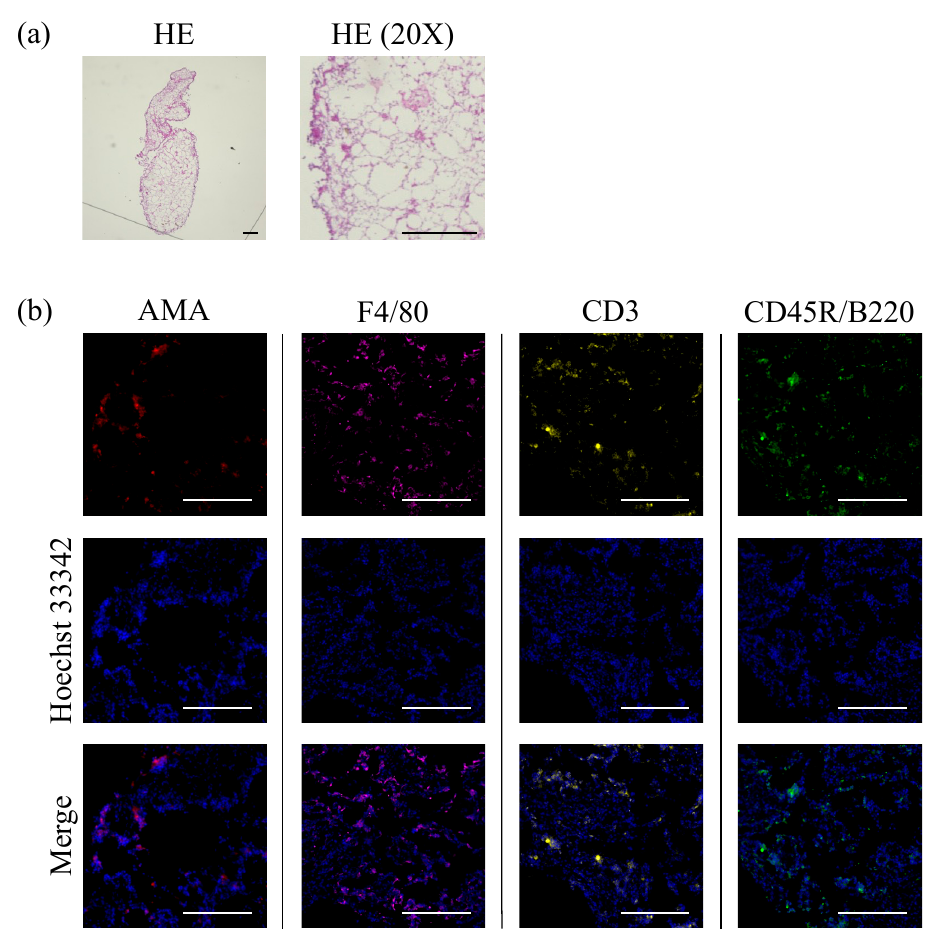
Figure 4. Microscopic analysis showing cellular aggregates. The aggregates were composed of immune cells (macrophages, T cells, and B cells) and human mitochondria-positive hAFSCs ( n = 5). ( a ) Representatives image of the aggregates obtained by staining with hematoxylin & eosin (HE) stain (Scale bar = 100 µm) ( b ) The aggregates contained anti-human mitochondrial antibody (AMA)-positive hAFSCs. They were also composed of F4/80 + peritoneal macrophages, CD3 + T cells, and CD45R/B220 + B cells (scale bar = 200 µm).